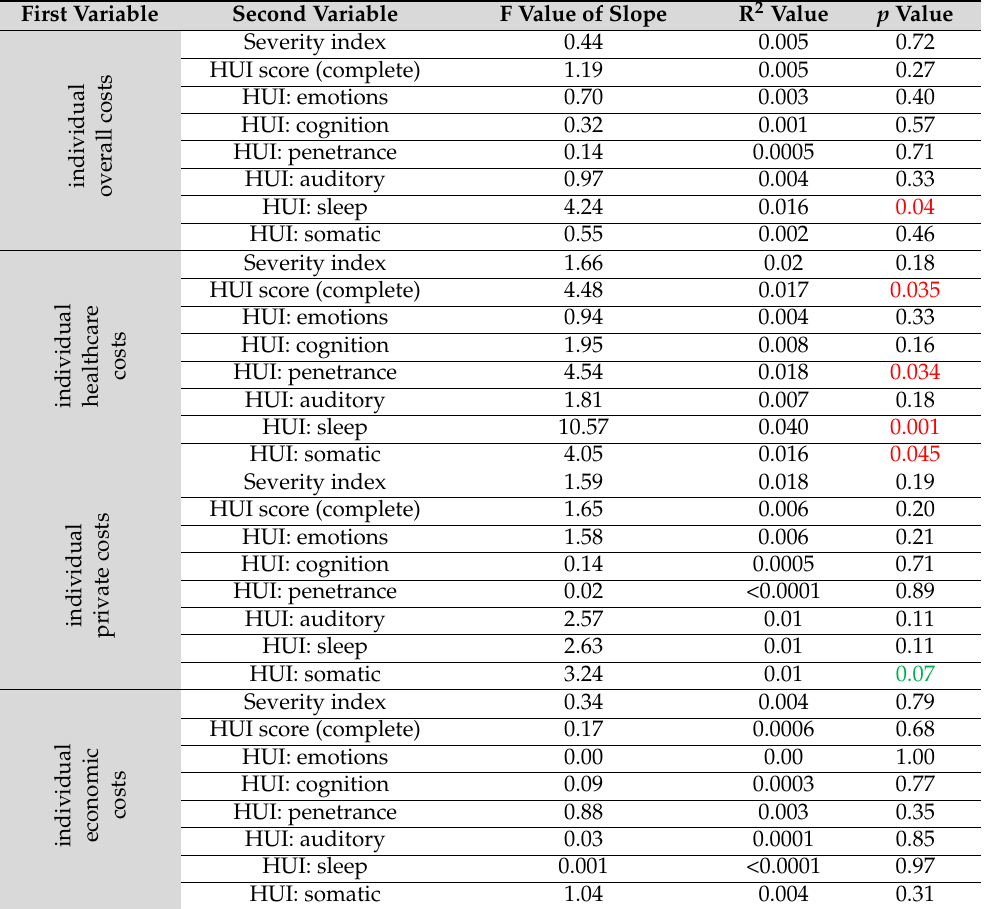
Table 6. Results of general linear model analyses of severity index and HUI scores vs. the different costs.